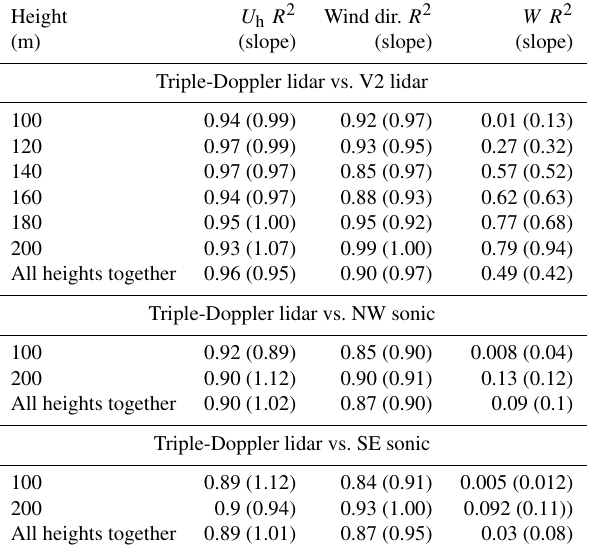
Table 6. Linear regression analysis of triple-Doppler lidar data against the reference instruments, namely sonic anemometers and V2